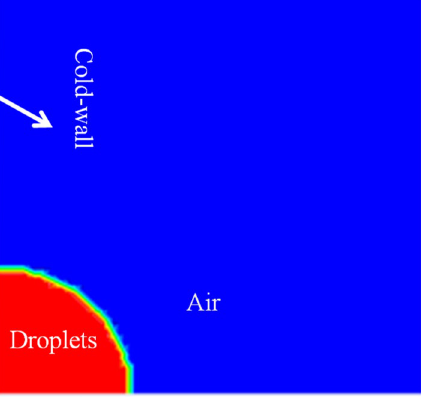
Figure 5. Initial phase.